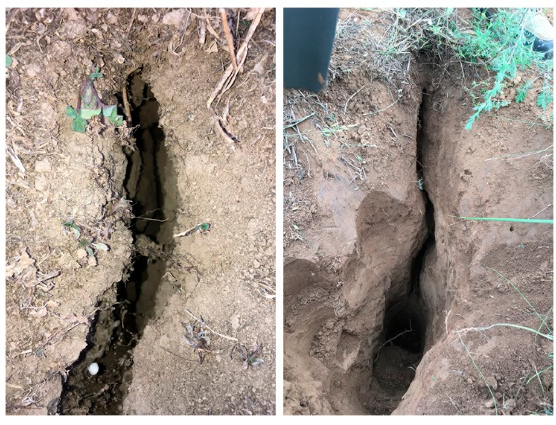
Figure 6. Surface cracks of the slide surface. Appl. Sci. 2020 , 10 , x FOR PEER REVIEW